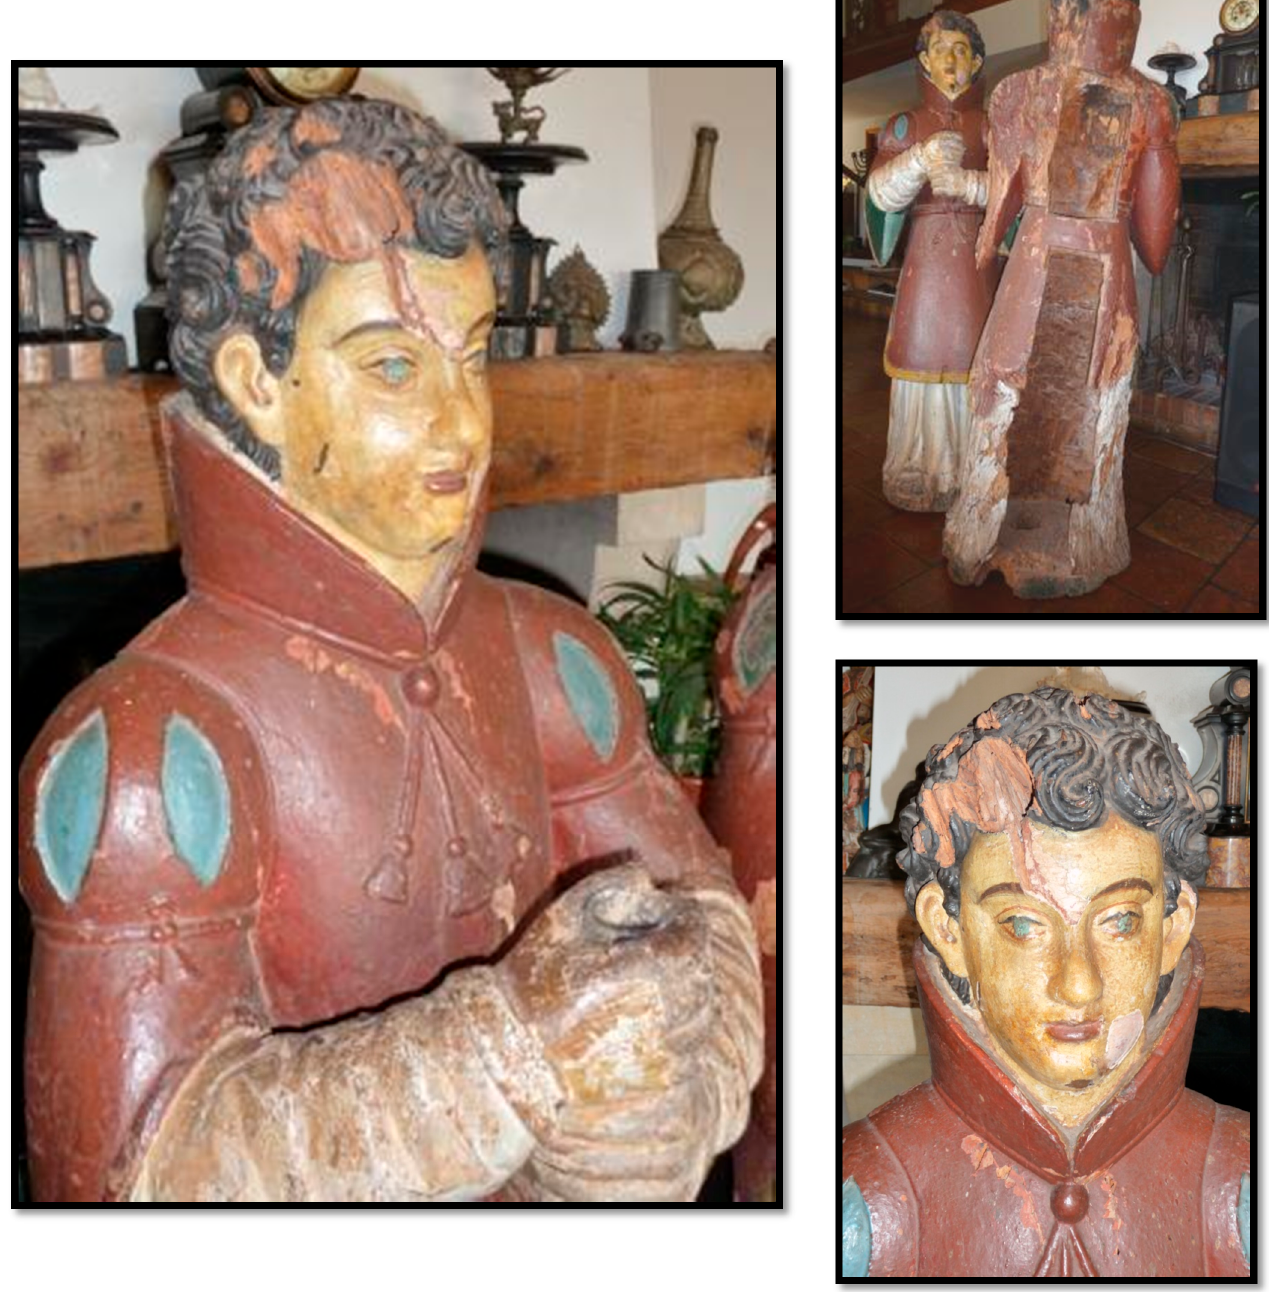
Figure 6. Polychrome teak statues from Goa, h.1.57 cm., w. at base 54 cm. Late 16th or 17th century, author’s collection. They were carved out of solid teak logs, which later tended to split due to fluctuations of temperature and humidity. By hollowing out the interior core, the damage could be reduced 4 . Like most of the solid wood statues of Goa, these life-size candle bearers have a rugged and rigid simplicity, lacking the fine details of delicate ivories that were created for European taste. Their sculptural style was clearly derived from indigenous Goan tra- dition and they have little in common with contemporary Portuguese art. The colors were periodically repainted, using the standard traditional pigments 5 . They were commis- sioned by the Church from local sculptors for altars and retables and often revealed ex-